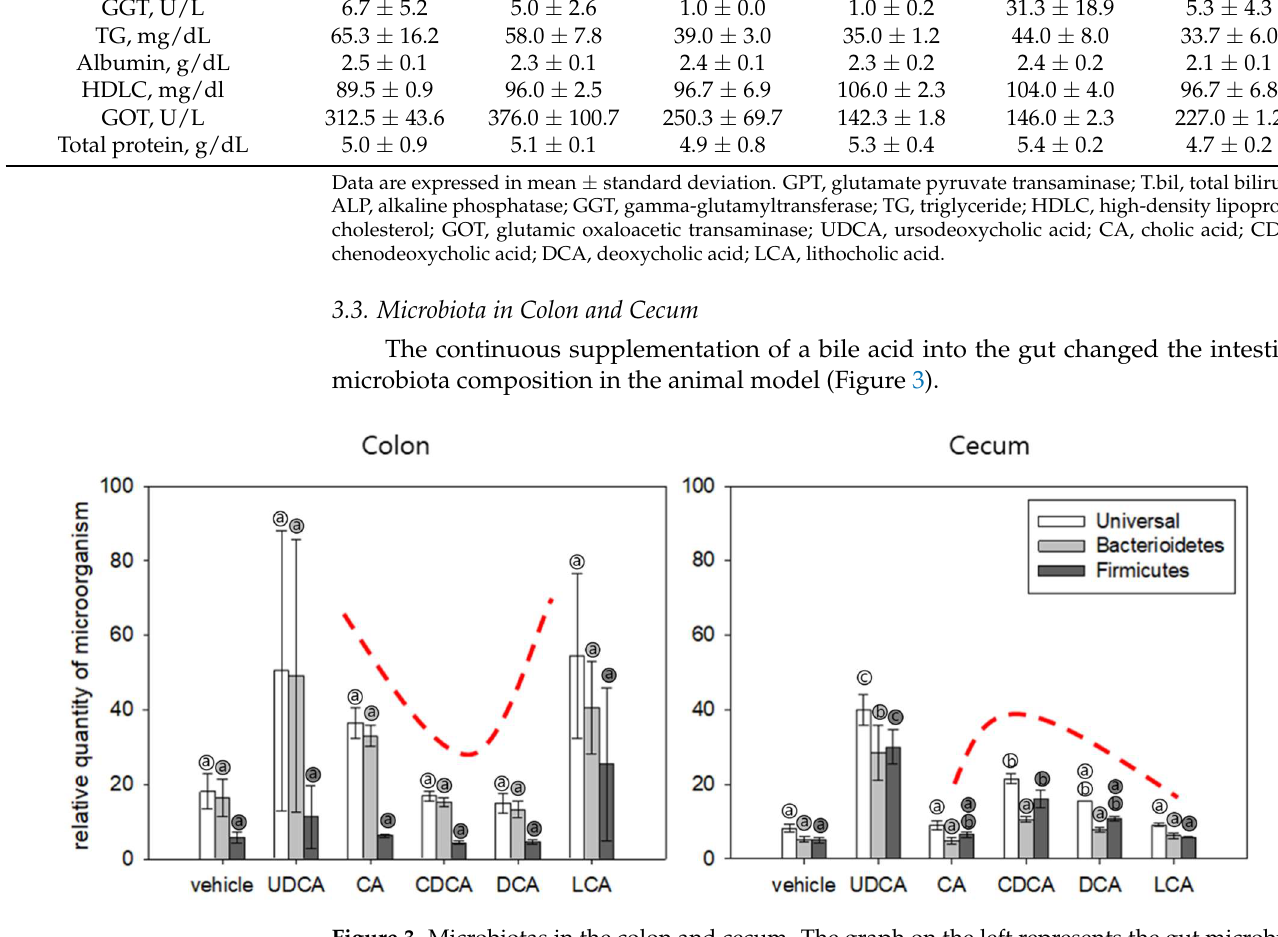
Figure 3. Microbiotas in the colon and cecum. The graph on the left represents the gut microbiota obtained from the colon when the mice were sacrificed, and the graph on the right represents the gut microbiota from the cecum. The horizontal axis indicates the group treated with each bile acid, and the vertical axis indicates the relative quantity of microorganisms. White bars represent quantification results using the universal bacterial primer for the genome sequence common to all bacteria, gray represents Bacteriodetes , and black represents Firmicutes . The same letters in the small shaded circle indicate a non-significant difference between groups, and significant differences were indicated with different letters. Each phylum was shaded the same as in the graph bars. Changes in microbial counts with bile acid administration were observed inversely in the colon and cecum except in the UDCA treatment group. (See the curve above the bar).